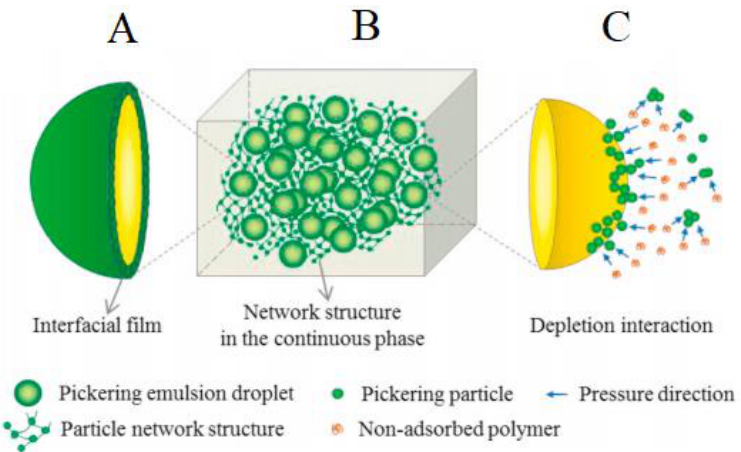
Figure 7. Schematic representation of the three possible stabilization mechanisms of Pickering emul- sions: ( A ) formation of the interfacial film; ( B ) formation of a 3D network structure; ( C ) stabilization by depletion interaction. Reproduced with permission from [71]. [Food Hydrocolloids]; published by [Elsevier, 2021].